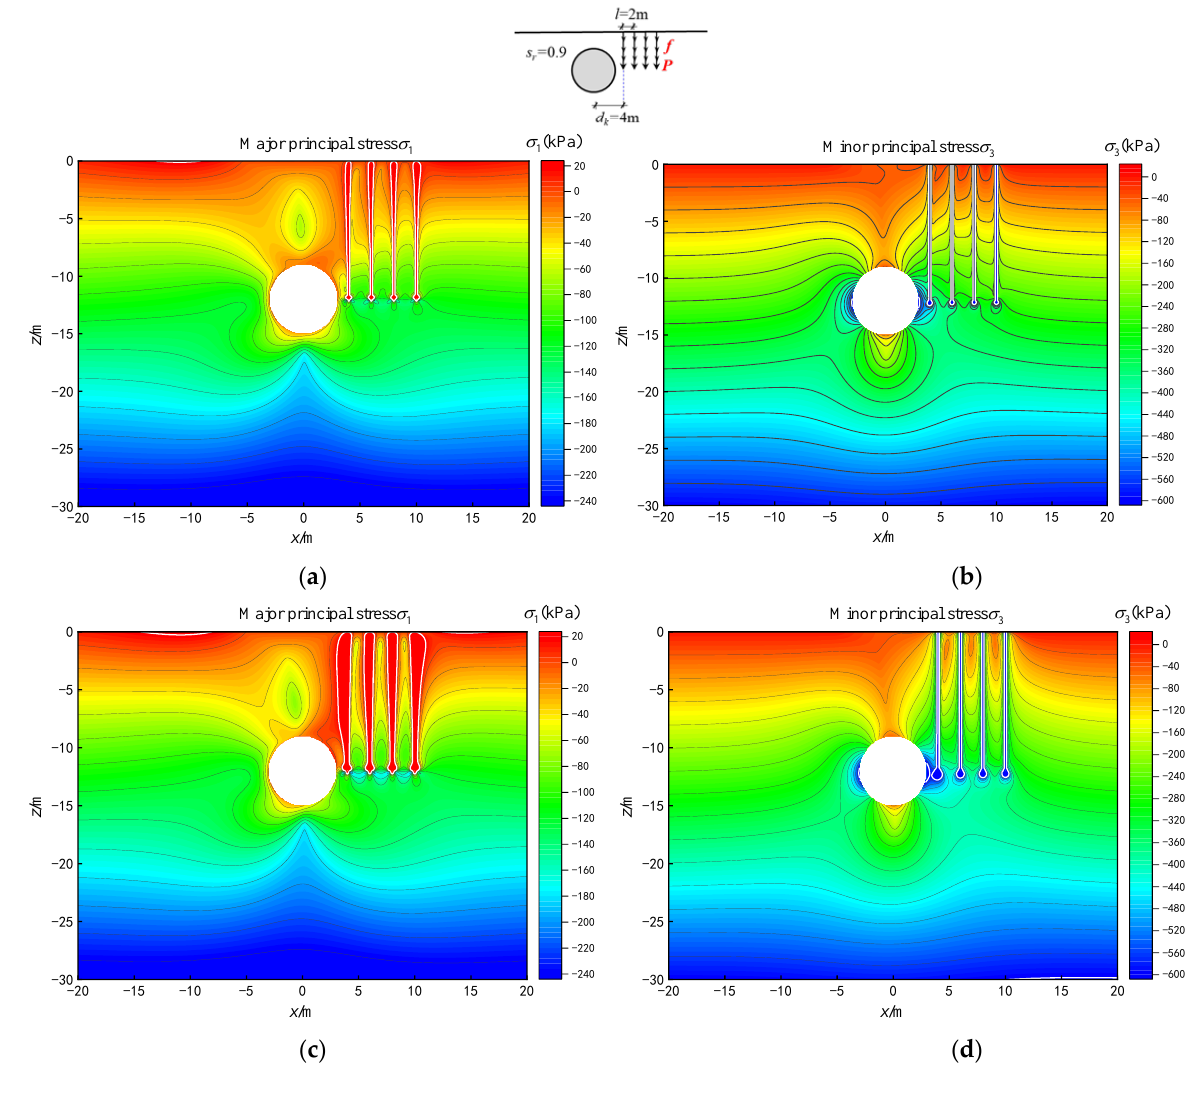
Figure 8. Contour diagrams of major and minor principal stresses with various pile group tip loads P and shaft shear loads f when s r = 0.9: ( a , b ) P = 150 kN, f = 70 kN/m; ( c , d ) P = 355 kN, f = 235 kN/m.